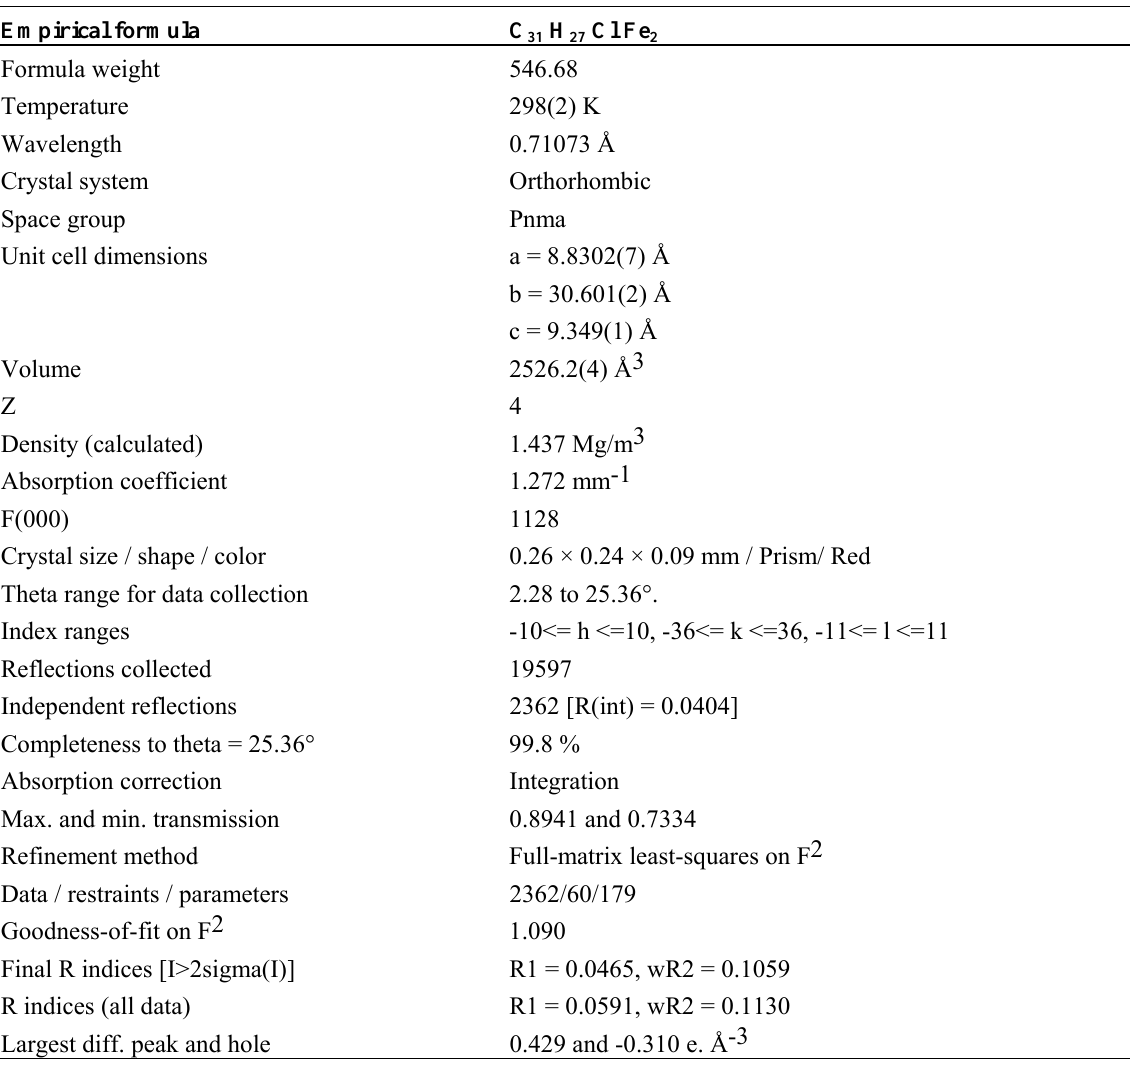
Table 2. Crystal data and structure